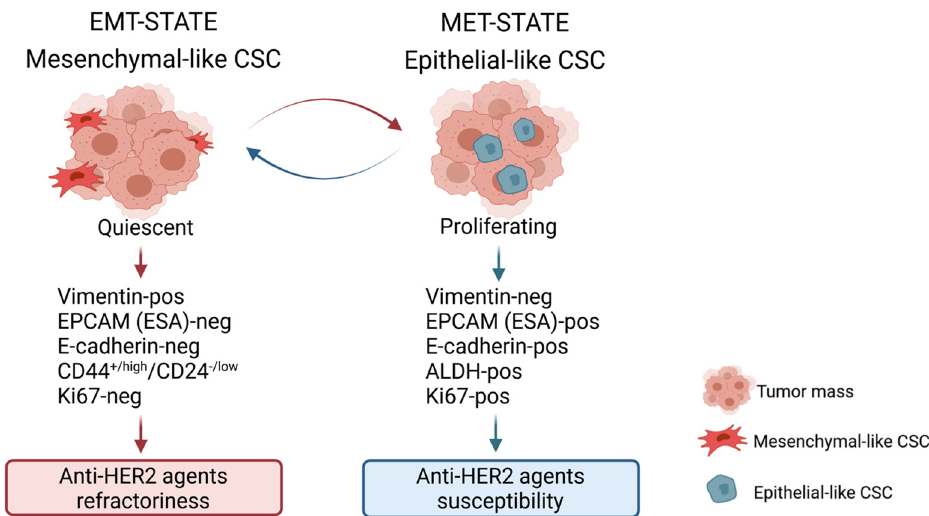
Figure 1. Characterization of BCSC states. Two different types of BCSCs have been identified: mesenchymal, quiescent cells with CD44 +/high /CD24 − /low phenotype that are particularly refractory to anti-HER2 agent treatment and preferentially localized at the edge of the tumor mass (EMT-STATE); and epithelial, proliferating type cells characterized by ALDH activity (ALDH-pos) that are more susceptible to anti-HER2 agents and preferentially localized within the tumor mass. Image created by Biorender.com.